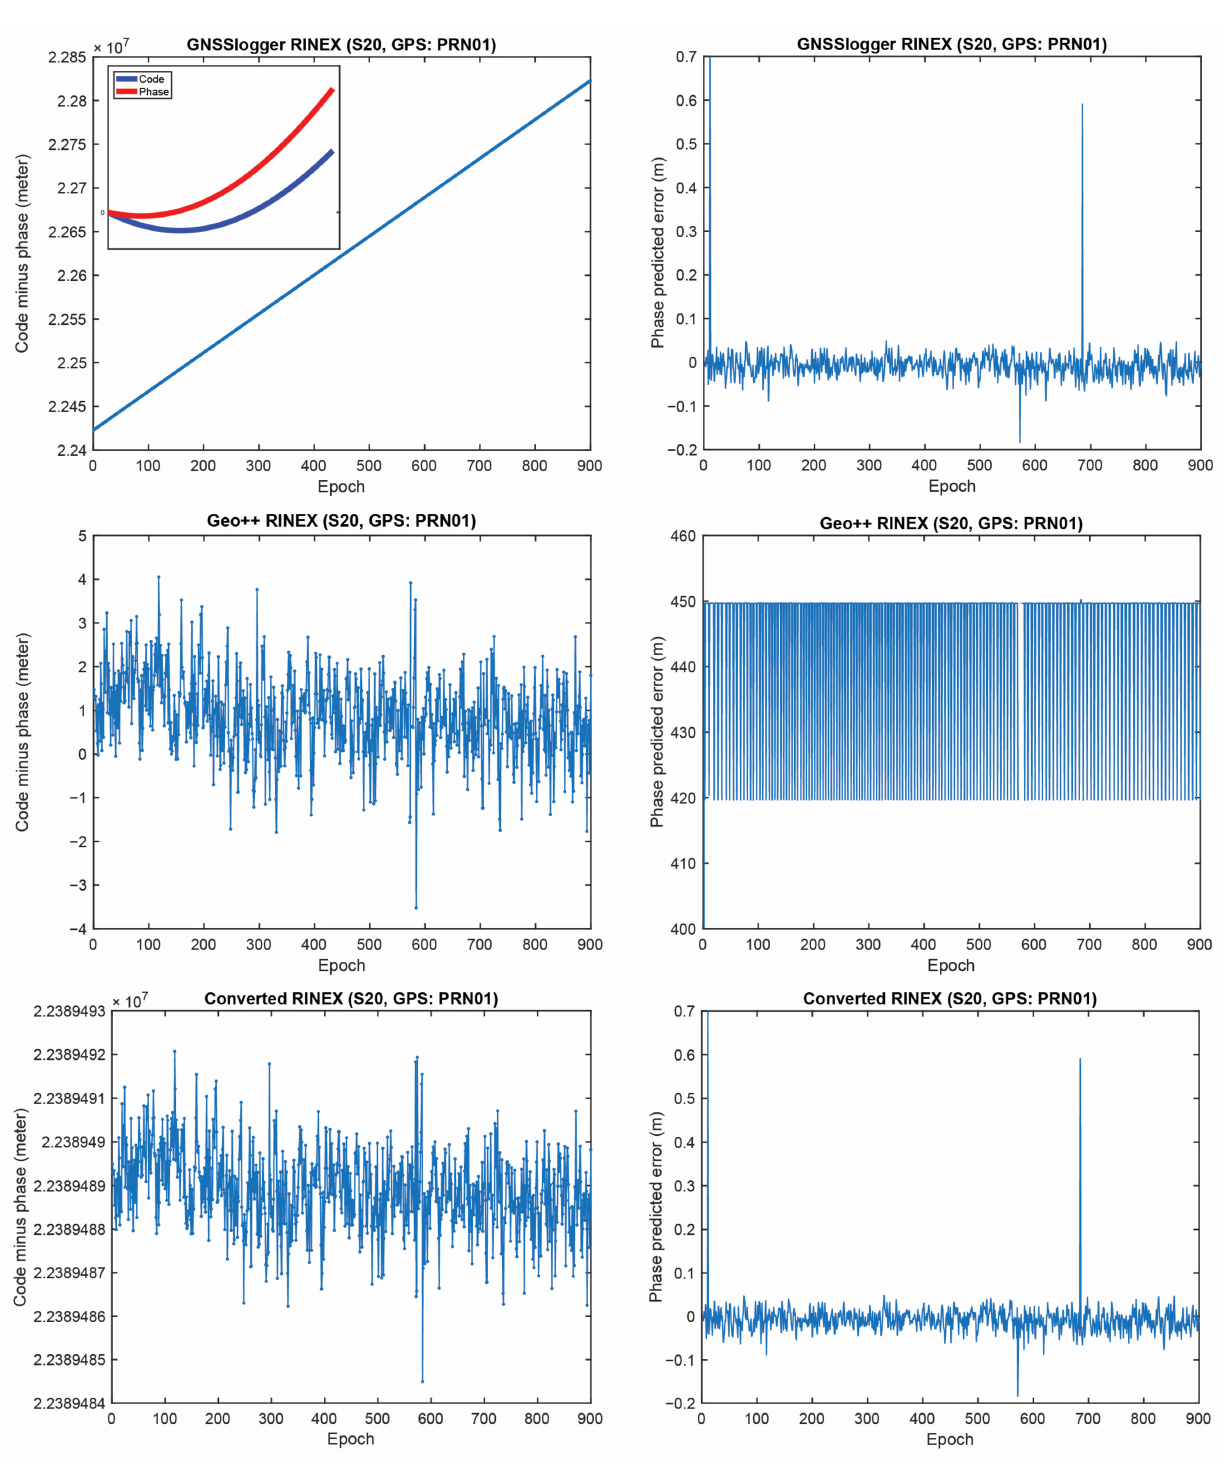
Figure 7. CMP carrier-phase predicted error for GPS PRNs 01 (Samsung